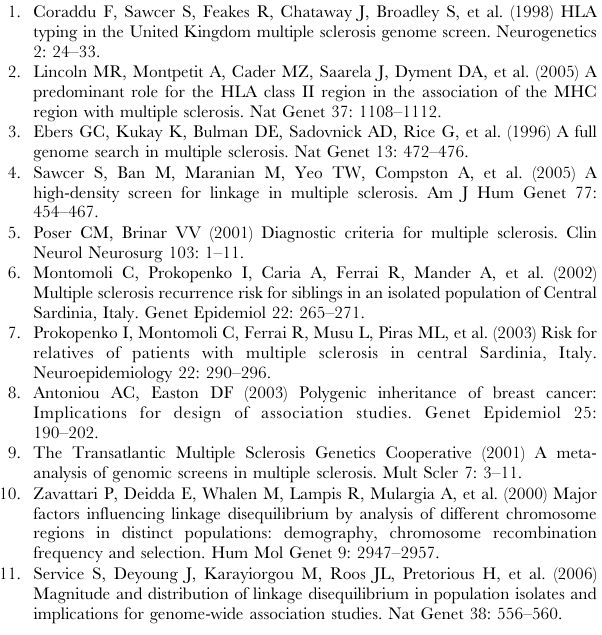
Table S2 Primer names and nucleotidic sequence used for ACCN1 exon resequencing.